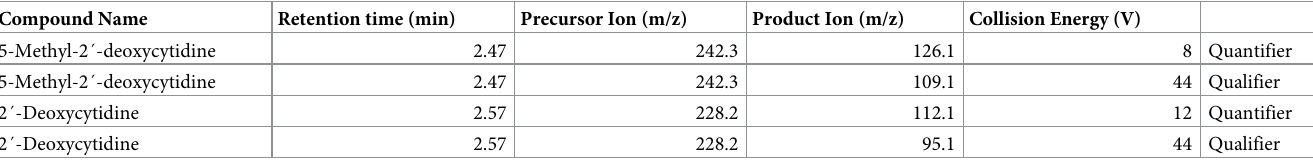
Table 2. Conditions of